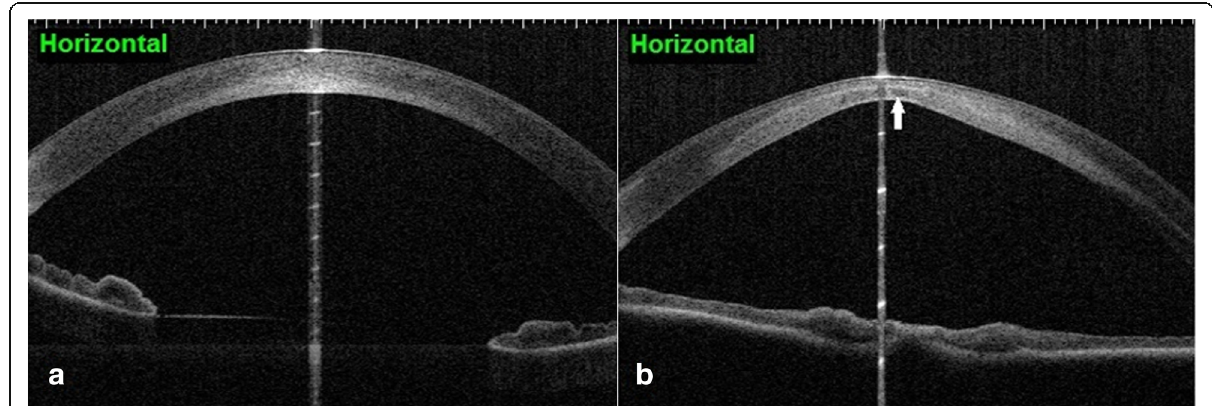
Fig. 3 Optical coherence tomography of the left eye at day of presentation ( a ) and at last control before keratoplasty ( b ) showing a cone-shaped bulge of the cornea with corneal thinning and increase of stromal hyper-reflexivity in the posterior part (arrow)